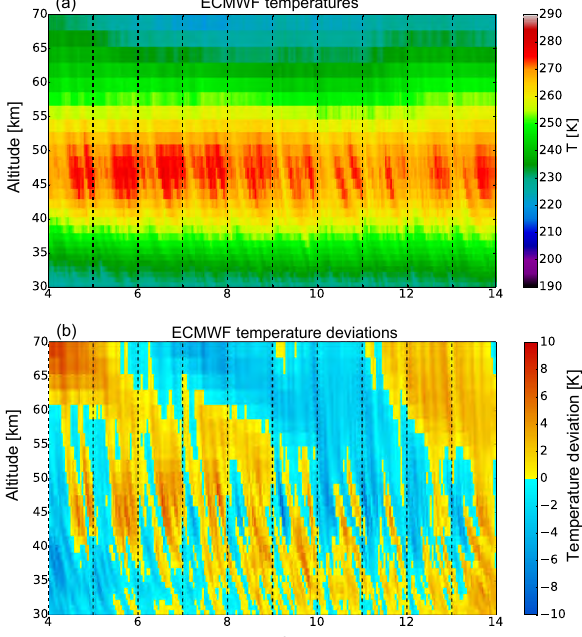
Figure 7. Temperature provided by the integrated forecast system of ECMWF (cycle 41r2) extracted with 1h temporal resolution on 4–13 May 2016 (a) and the calculated temperature deviations from the mean temperature (b) .